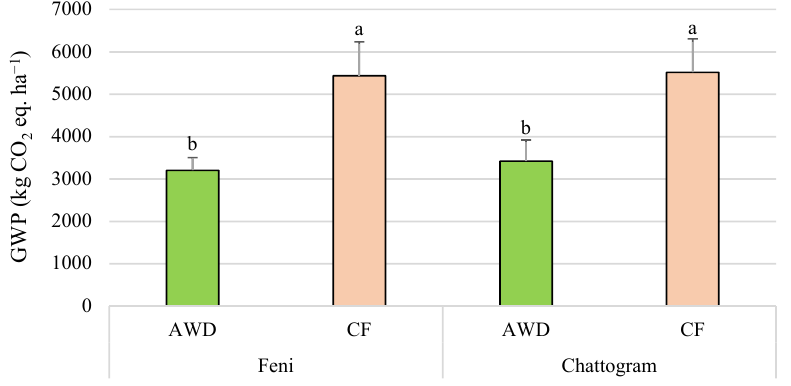
Figure 6. Effect of AWD and CF irrigation methods on the GWP from the paddy field at Feni and Chattogram. Means with different letters indicate significant differences at the 5% level.